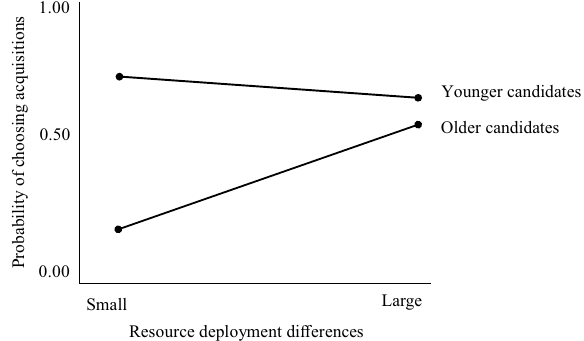
Fig. 2. The moderating effect of relative firm age on the relationship between resource deployment differences and the ally-versus-acquire choice